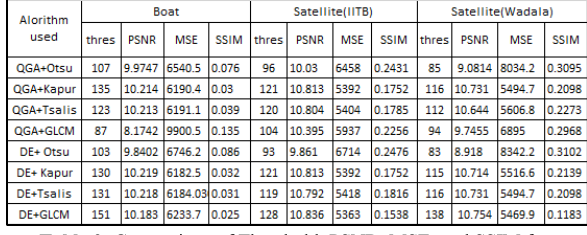
Table 2 : Comparison of Threshold, PSNR, MSE, and SSIM for different algorithm